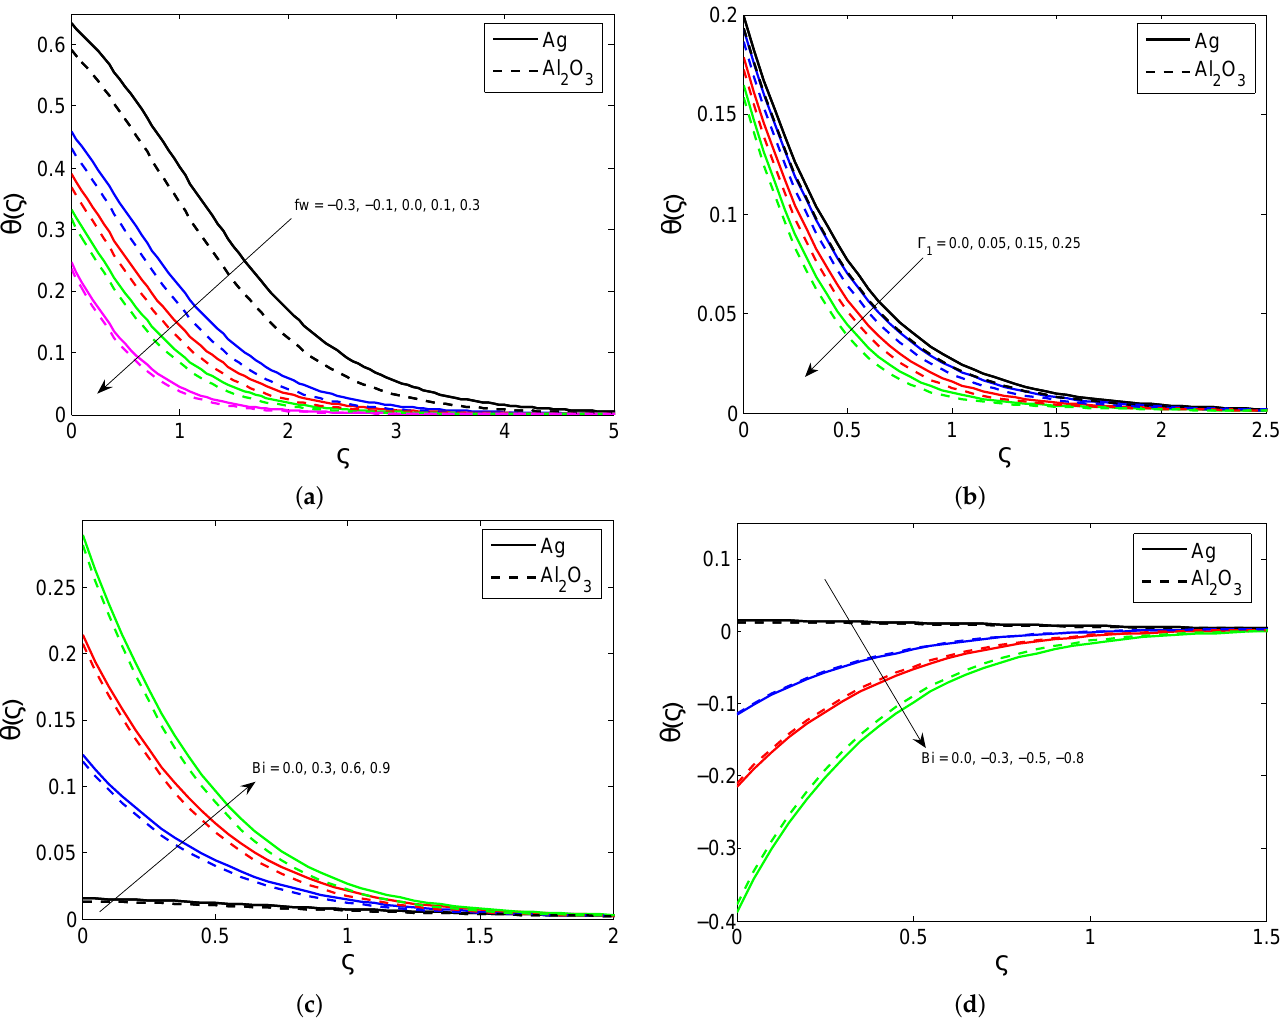
Figure 5. The variation of θ ( ς ) in relation to ( a ) fw , ( b ) Γ 1 , ( c ) Bi (convective heating) and ( d ) Bi (convective cooling).